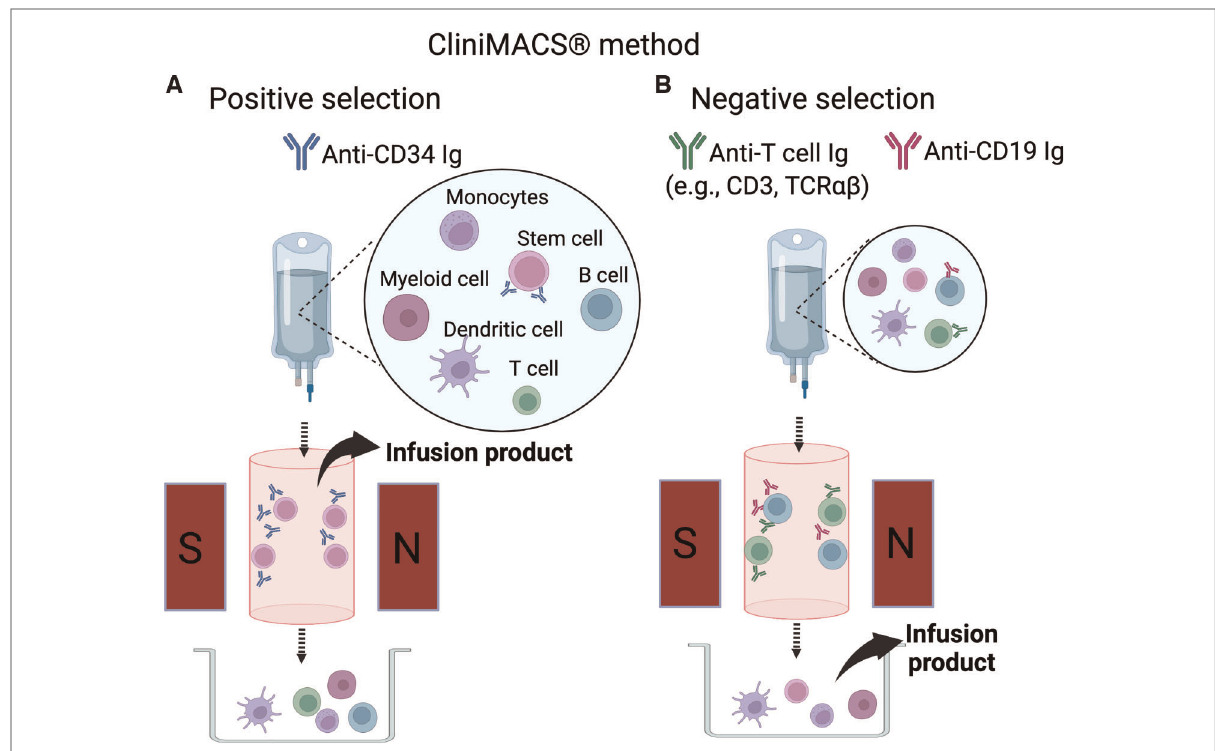
FIGURE 2 CliniMACS method. ( A ) The positive selection method (CD34+ selection). Donor marrow or G-CSF mobilized peripheral blood mononuclear cells are stained with anti-CD34 antibody conjugated with magnetic beads. CD34+ cells bound to the antibody-bead complex are captured in the magnetic fi eld on the column. The cells retained in the magnetic fi eld are released from the magnet and collected for infusion. ( B ) The negative selection method. Bone marrow or peripheral blood mononuclear cells are stained with anti-T cell antibody (e.g., anti-CD3 or anti-TCR αβ ) and anti-CD19 antibody are used as antibody-magnetic bead complex. The cells bound to the antibody-bead complex are captured in the magnetic fi eld. The cells not captured on the magnetic fi eld of the column are collected for